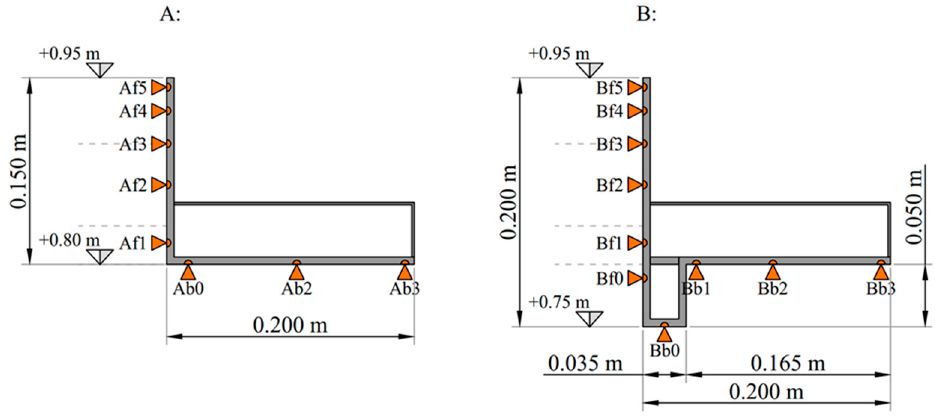
Figure 3. Tested crest wall cross-sections and location of the pressure transducers [5].